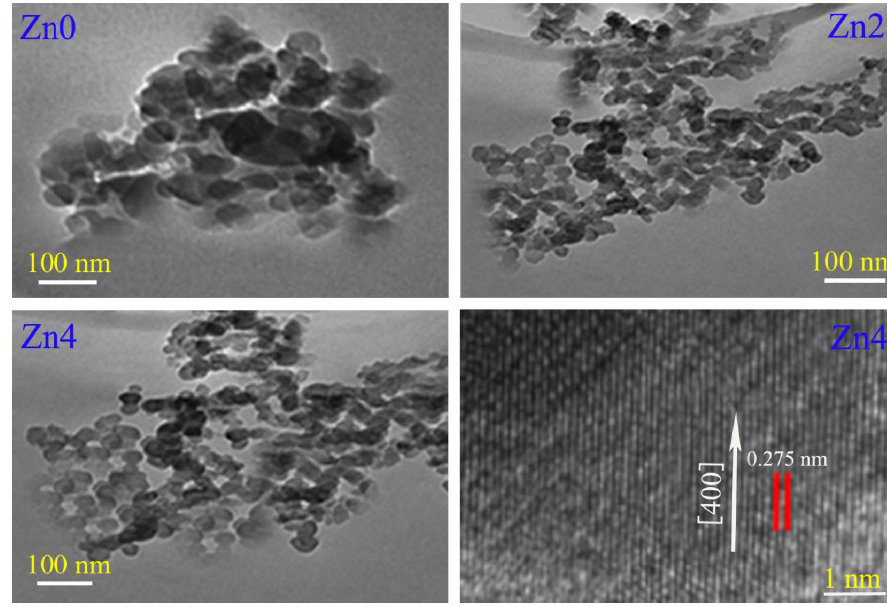
Figure 3. TEM and HRTEM images of Zn 0 , Zn 2 and Zn 4 samples.